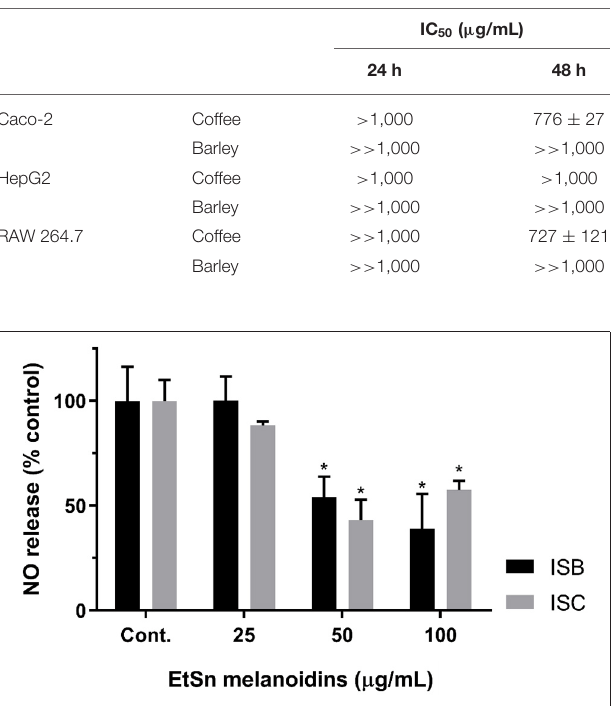
TABLE 3 | IC 50 values of ISC and ISB EtSn melanoidin populations in different cell lines and exposure times.